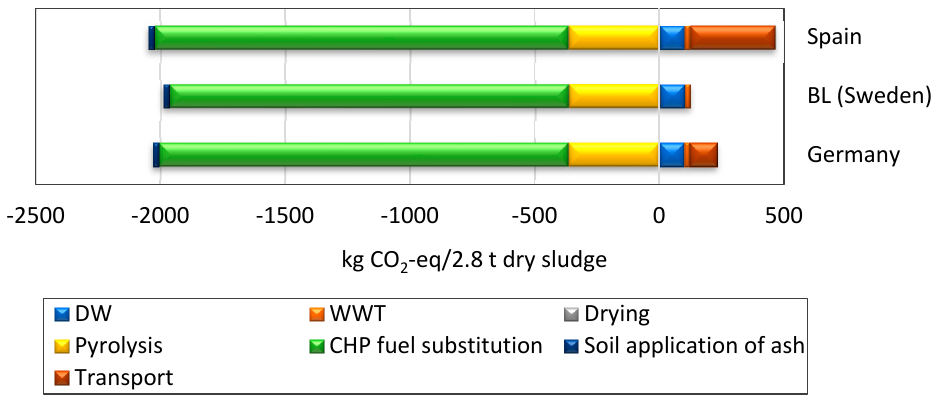
Figure 8. Sensitivity of the climate change effect of Pyrochar Scenario to the location of CHP plant within the EU region (Spain and Germany).